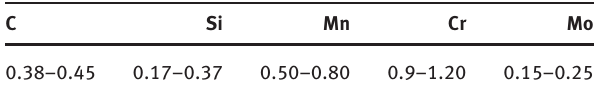
Table 1: Chemical compositions (mass%) of